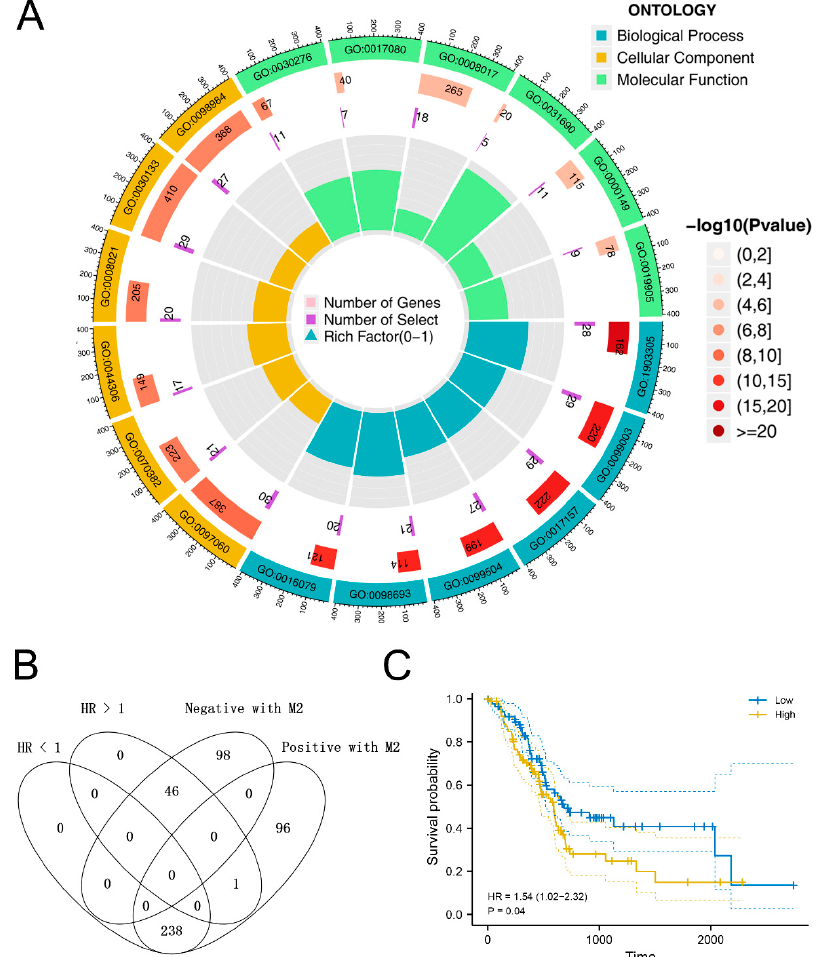
Figure 3. Identification of the M2 macrophage-related genes. Notes: ( A ) GO and KEGG analysis of M2 macrophages-related genes; ( B ) TMIGD3 was positively correlated with M2 macrophages and also a risk factor for PC; ( C ) KM survival curves of TMIGD3 in PC.